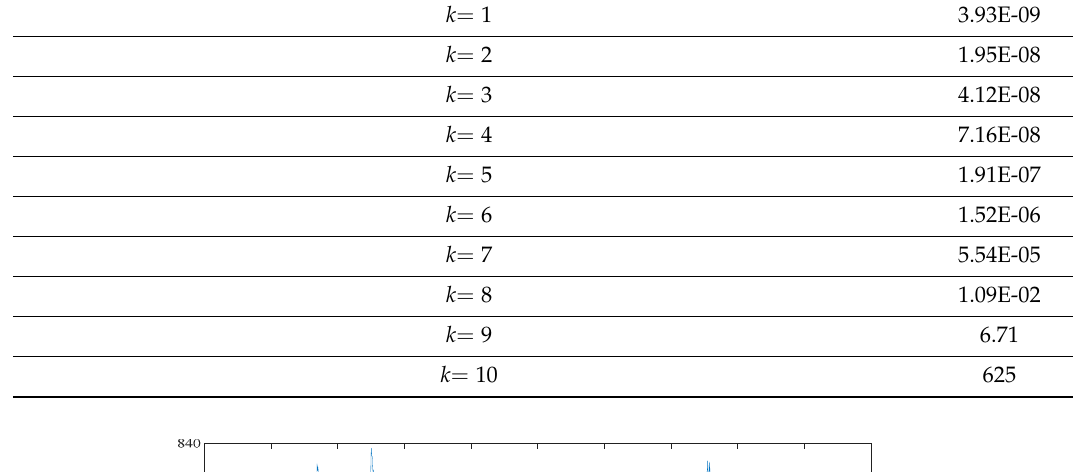
Table 1. The variances of the sums of the singular spectrum analysis components under the unit energy normalization.